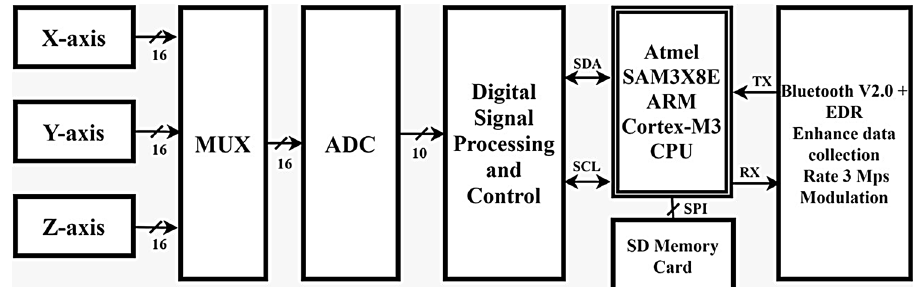
Fig. 1 Block diagram system for the mobile robot